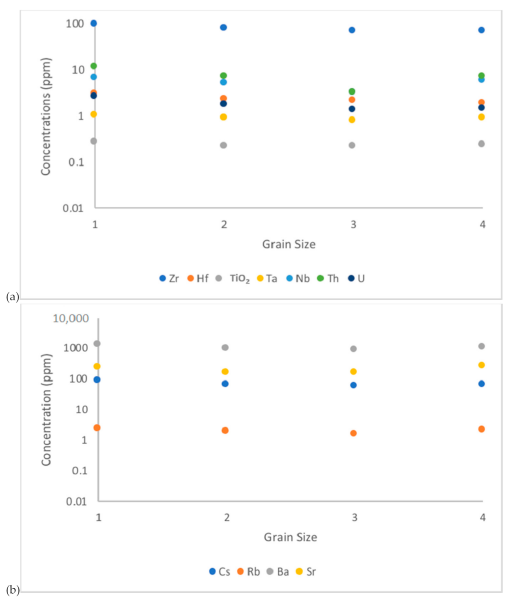
Figure 7. Grain size vs concentrations of Zr, Hf, TiO 2 (%) ( a ), Ta, Nb, Th, U, Cs, Rb, Ba and Sr ( b ) (all the trace elements concentrations are in ppm). Symbols as in Figure